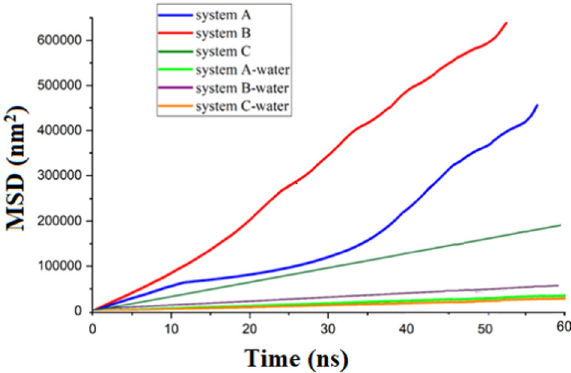
Fig. 5 MSD pattern. Time evolutions of MSD for the different ions and water molecules in the simulated systems.